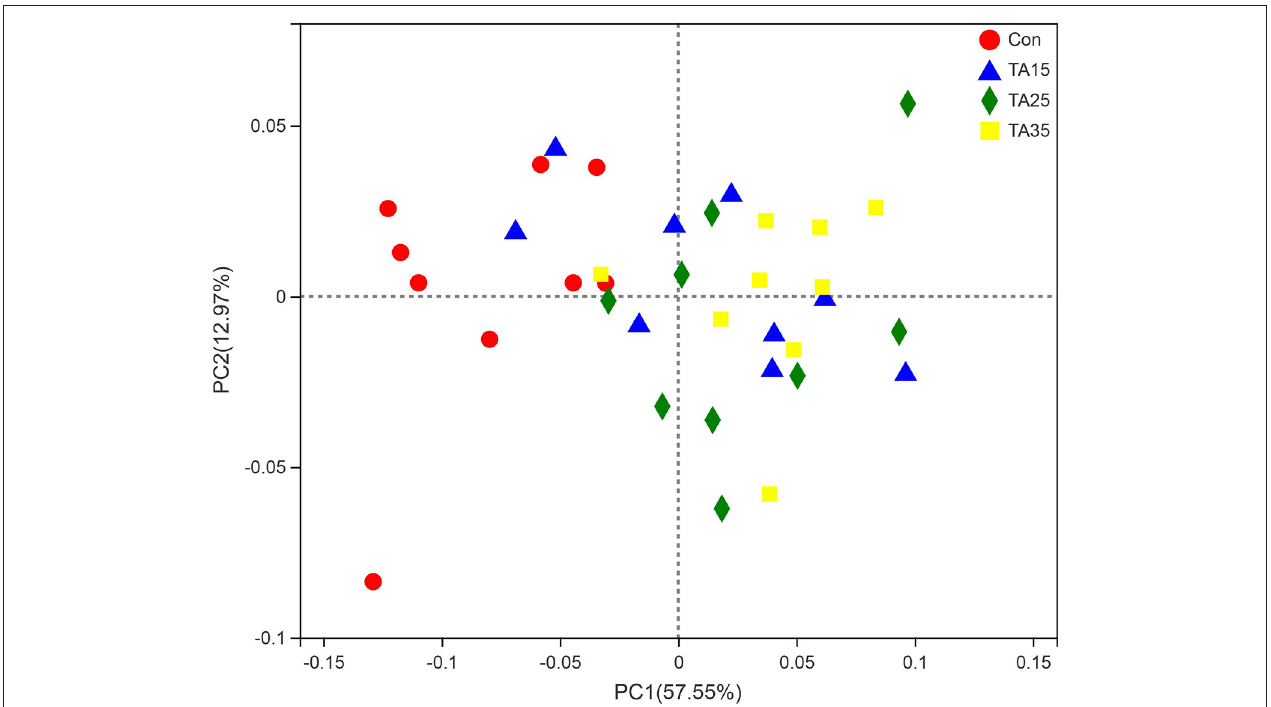
FIGURE 2 | Principal coordinate analysis (PCoA) of bacterial community structures of the ruminal microbiota in CON (red circles), TA15 (blue triangle), TA25 (green diamond), and TA35 (yellow square) groups. PCoA plots were constructed using the weighted UniFrac method.